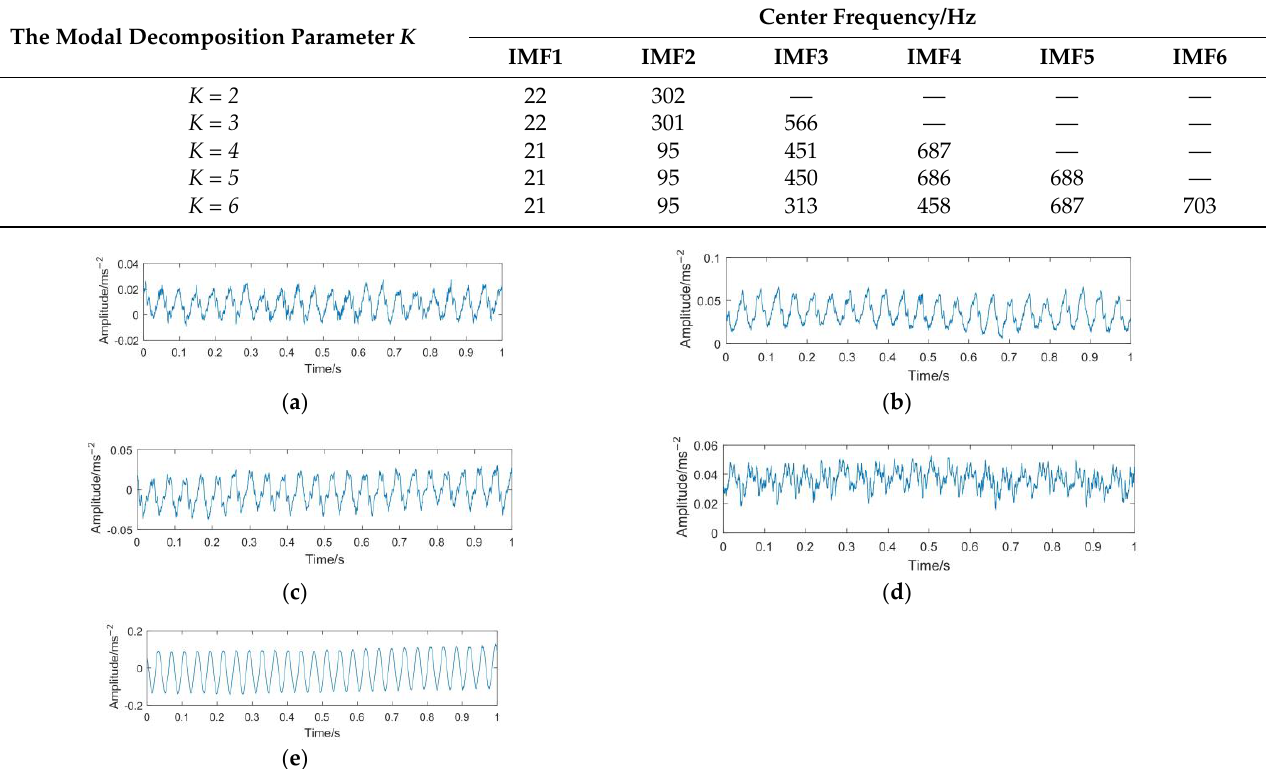
Table 5. The center frequency of each IMF component corresponds to different K values.